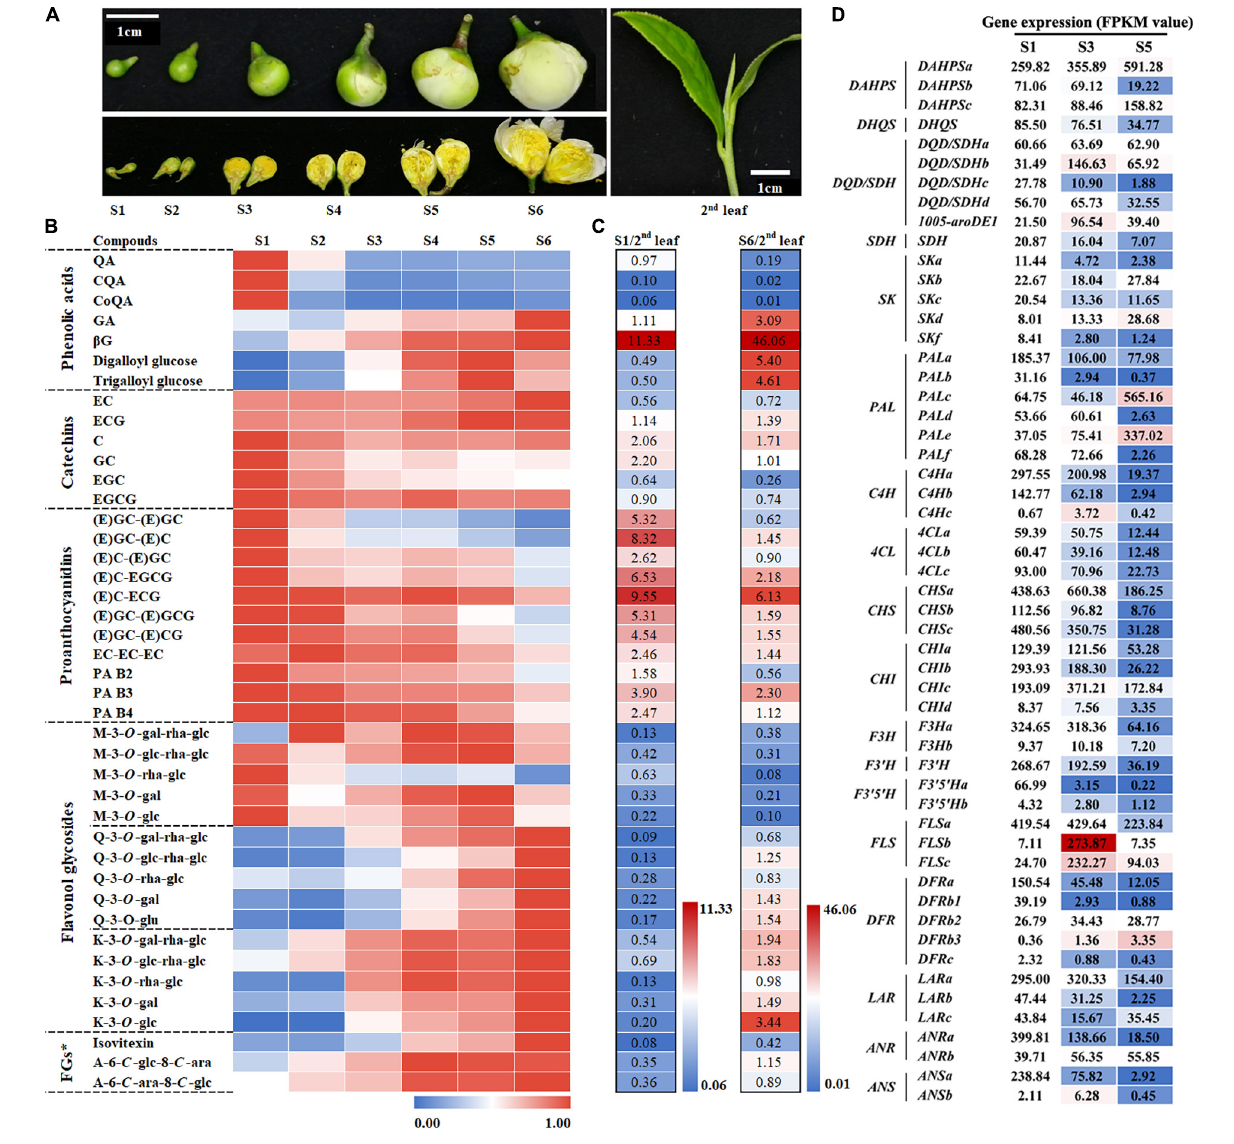
FIGURE 2 | Metabolic analysis of phenolic compounds and expression analysis of related biosynthetic genes at different flower bud developmental stages. (A) Phenotypes of different stages of flower buds and the second leaf. S1–S6 represent developmental stages 1–6, respectively. (B) Characteristics of phenolic compound accumulation in different flower developmental stages. The peak area data were processed and fall into an interval of 0–1 according to the ratio. FGs*, Flavone glycosides. (C) Comparison of the phenolic compound accumulation between S1 or S6 and the second leaf. (D) Expression analysis of genes in the shikimate, phenylpropanoid, and flavonoid pathways at different flower development stages. The value represents the FPKM value. The S1 FPKM value of each gene transcript was defined as numerical value 1, and the stage 3 and S5 FPKM values were converted